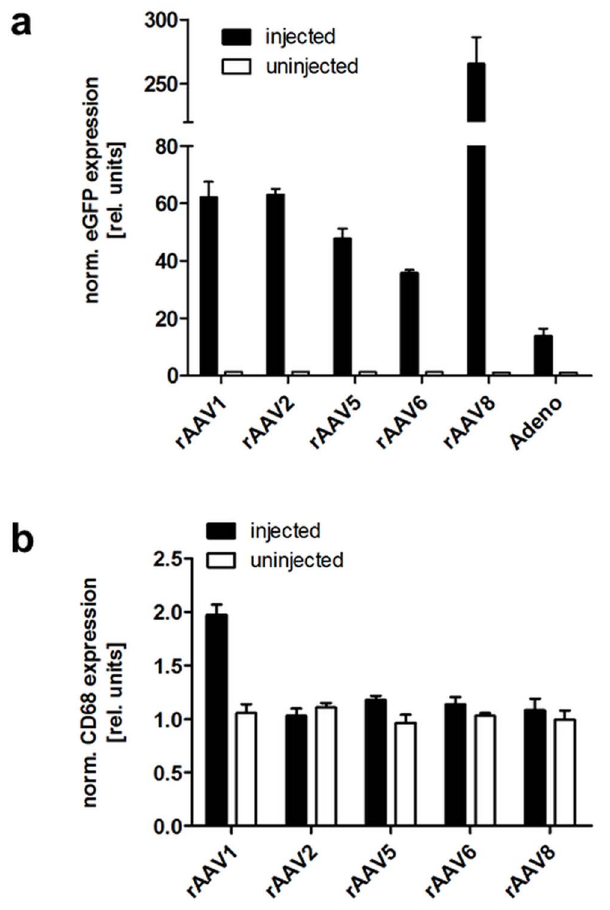
Fig. 1. Local application of rAAV serotypes 1, 2, 5, 6 and 8 and rAd into visceral fat pads. C57BL/6 mice were injected with 4.2 6 10 10 VG per fat pad of rAAV-CMV-eGFP vectors or rAd-CMV-eGFP, respectively. Four weeks post-injection, mice were sacrificed and eGFP (a) or CD68 expression (b) was determined in cDNA from injected (black bars) and non-injected (white bars, not visible in panel a) fat pads by qPCR analysis. Normalization to the housekeeping gene 36B4 was performed and relative gene expression is depicted in the graph. Values indicate the mean of three animals, error bars show SEM.